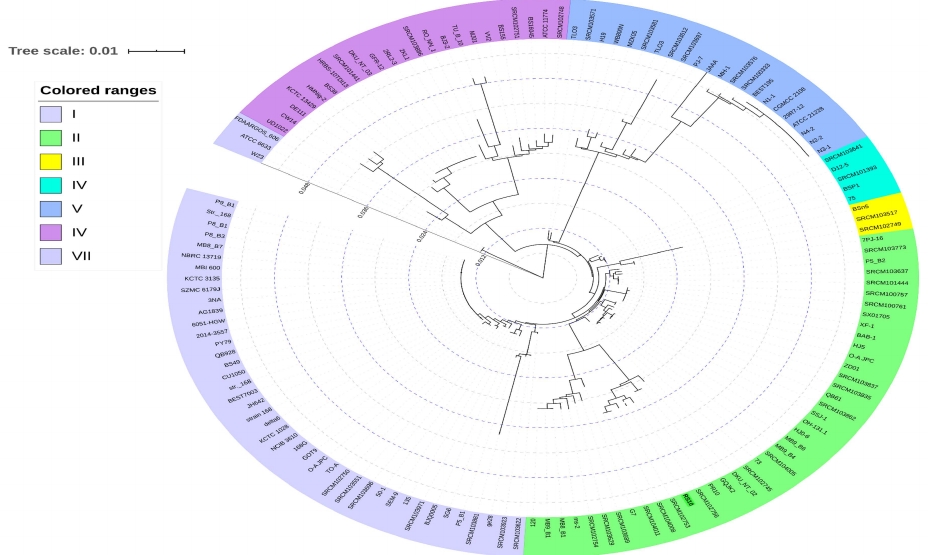
Figure 6. The evolutionary history was inferred using the Maximum Likelihood method and JTT matrix-based model. The tree with the highest log likelihood (-122314.01) is shown. Initial tree(s) for the heuristic search were obtained automatically by applying Neighbor-Join and BioNJ algorithms to a matrix of pairwise distances estimated using a JTT model, and then selecting the topology with a superior log-likelihood value. The tree is drawn to scale, with branch lengths measured in the number of substitutions per 100